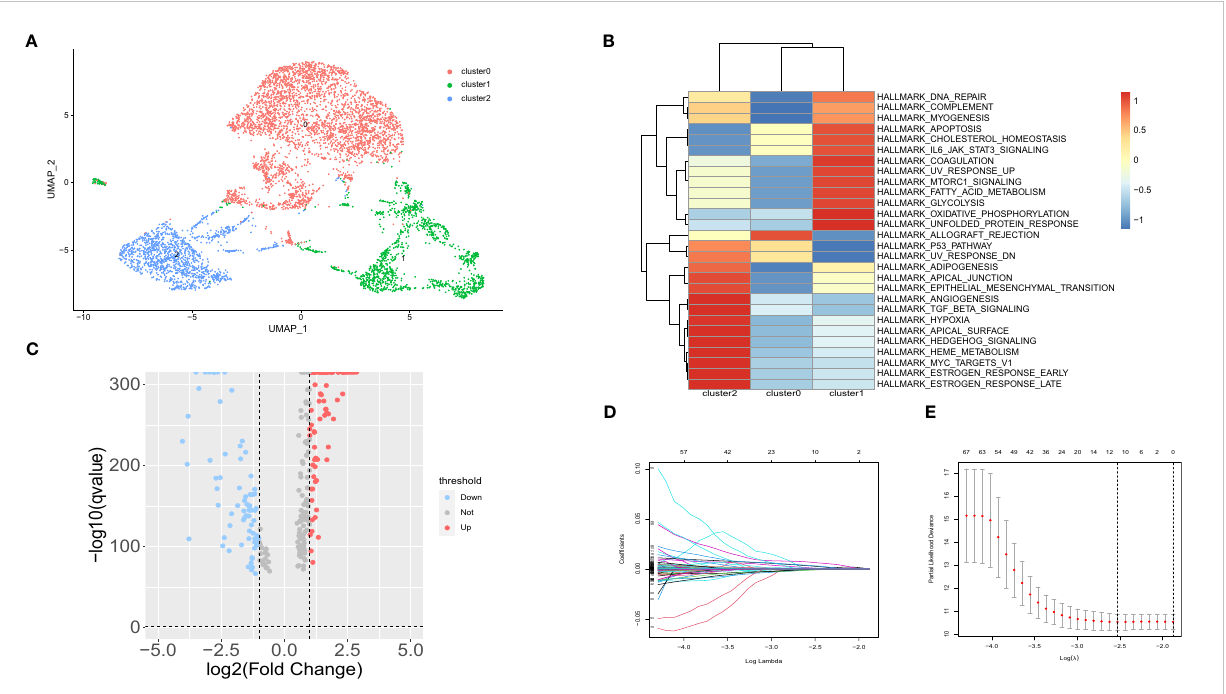
FIGURE 3 Subpopulation analysis in fi broblast subtypes. (A) UMAP of 3 fi broblast clusters. (B) Hallmarks enriched by GSVA in 3 fi broblast clusters. (C) Volcano maps of up- and downregulated genes in fi broblast Cluster 2. (D) LASSO coef fi cient distribution of each independent gene. (E) The partial likelihood deviance in LASSO Cox regression